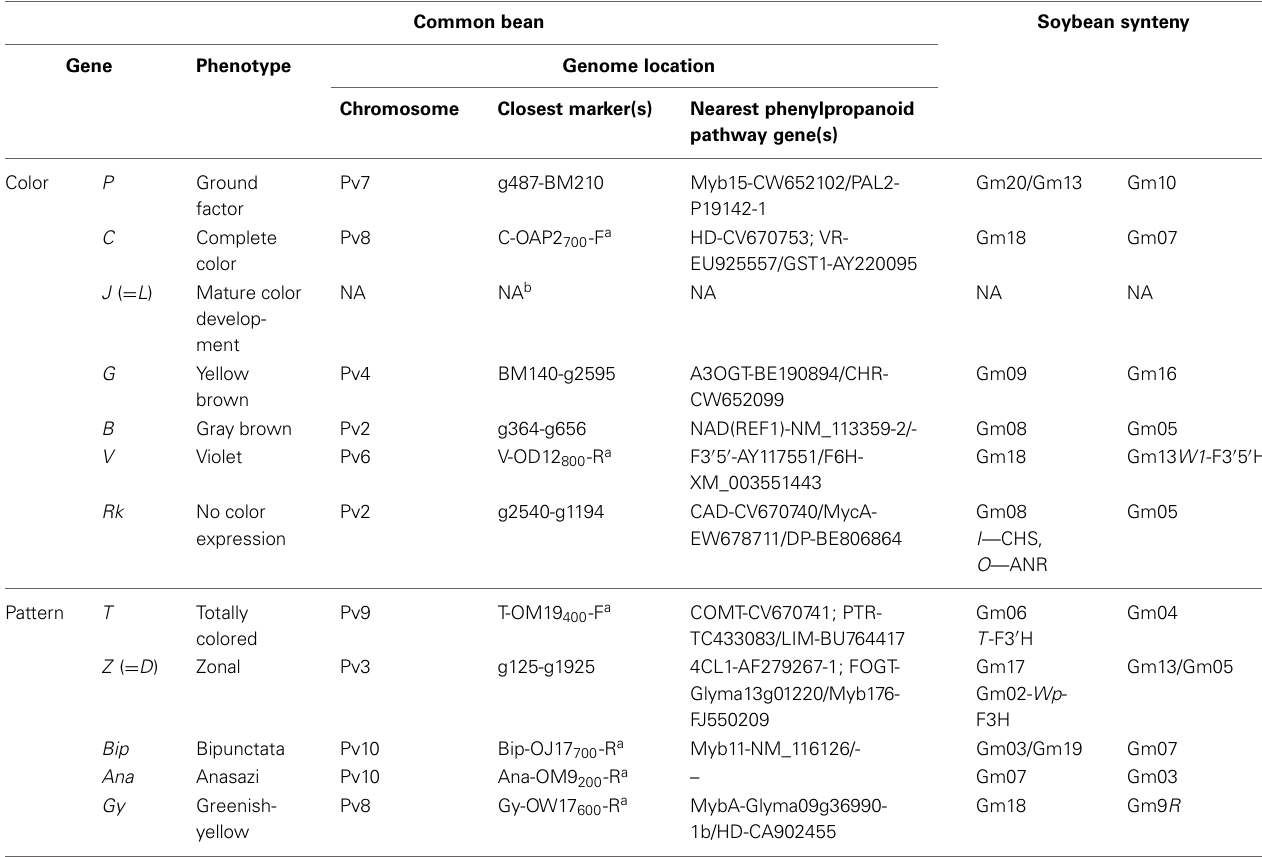
Table 6 | Genome location of common bean seed coat color and pattern